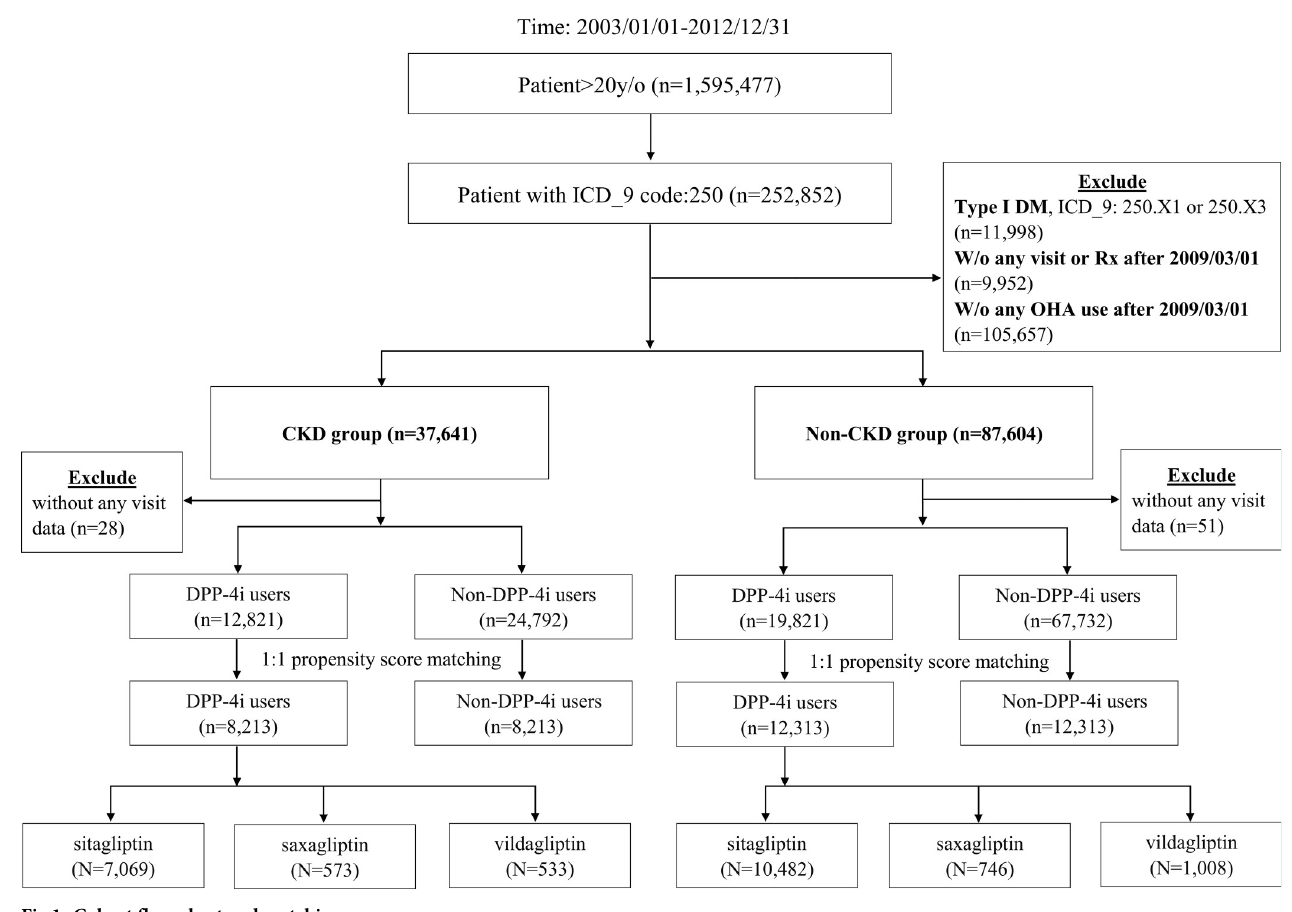
Fig 1. Cohort flow-chart and matching.